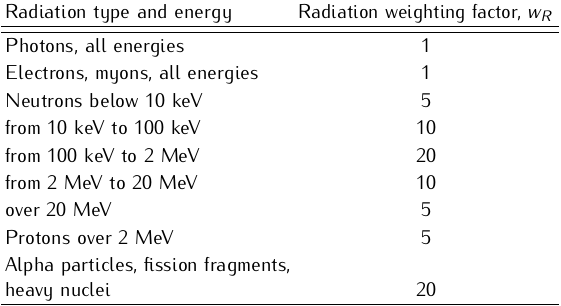
Table 1. Radiation weighting factors w